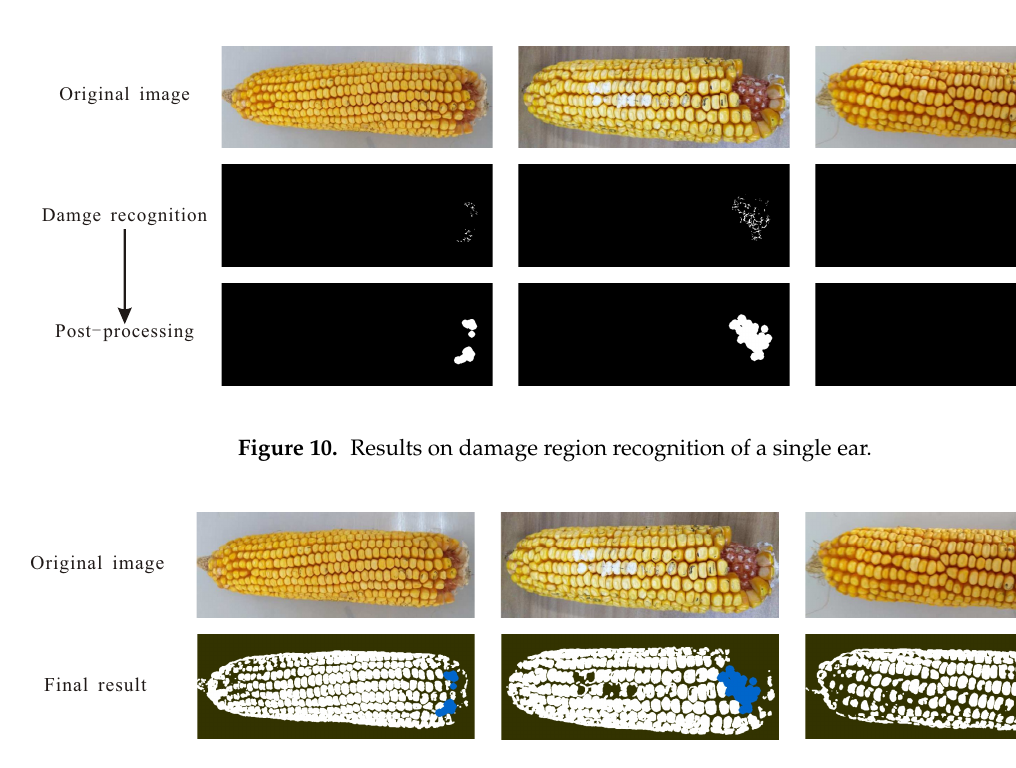
Figure 9. Results on kernel recognition of a single ear.